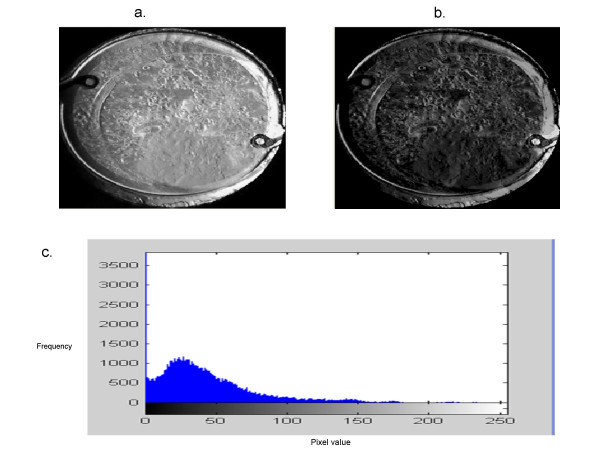
a. Original greyscale image, b. background removed, c. image histogram